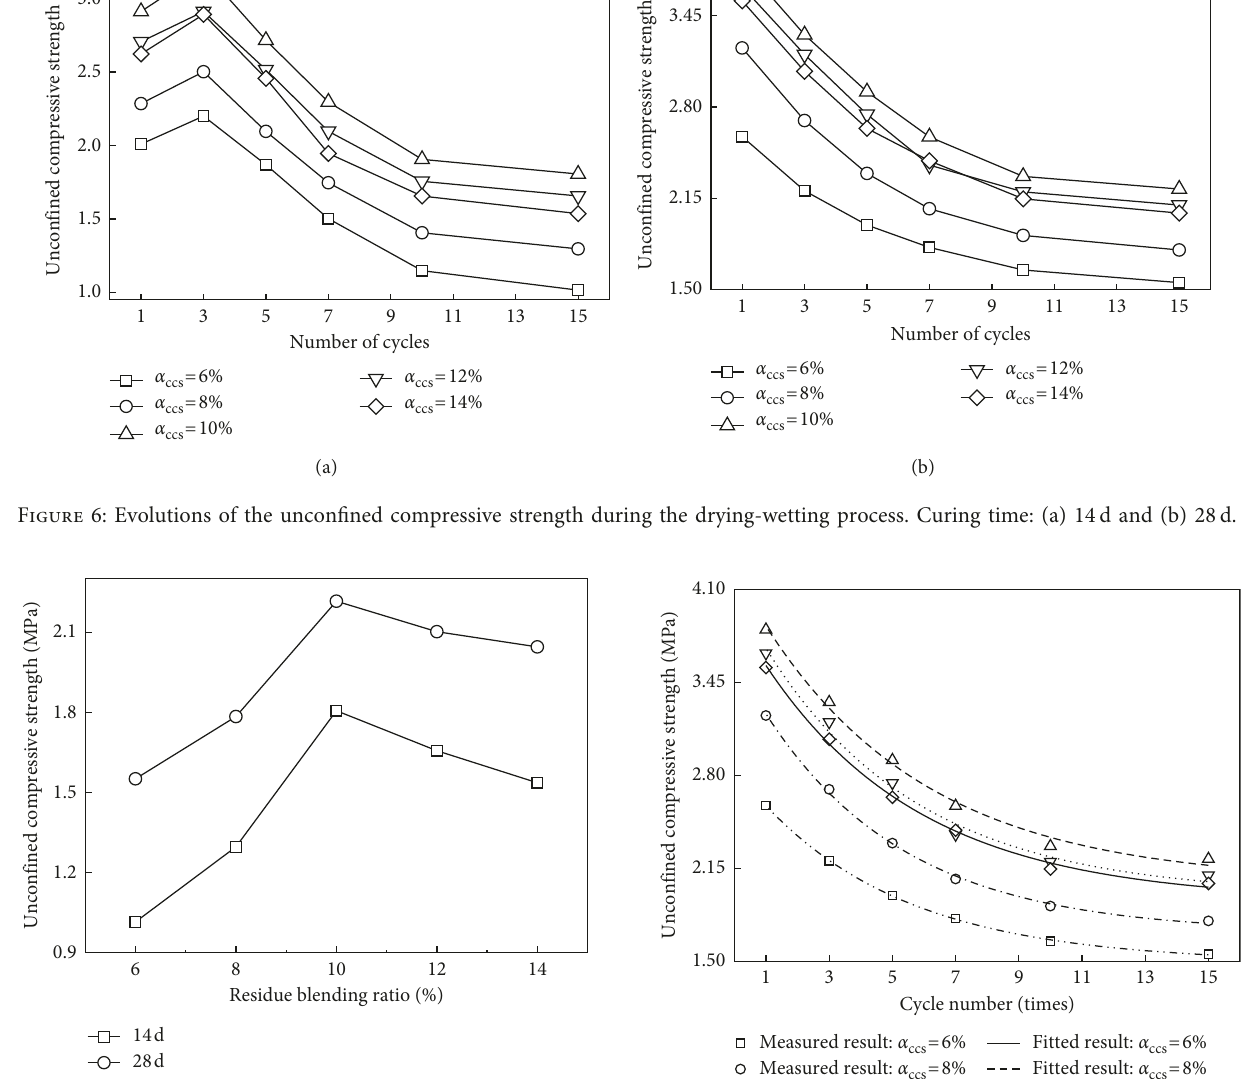
Figure 7: Evolutions of strength with the calcium carbide slag content.